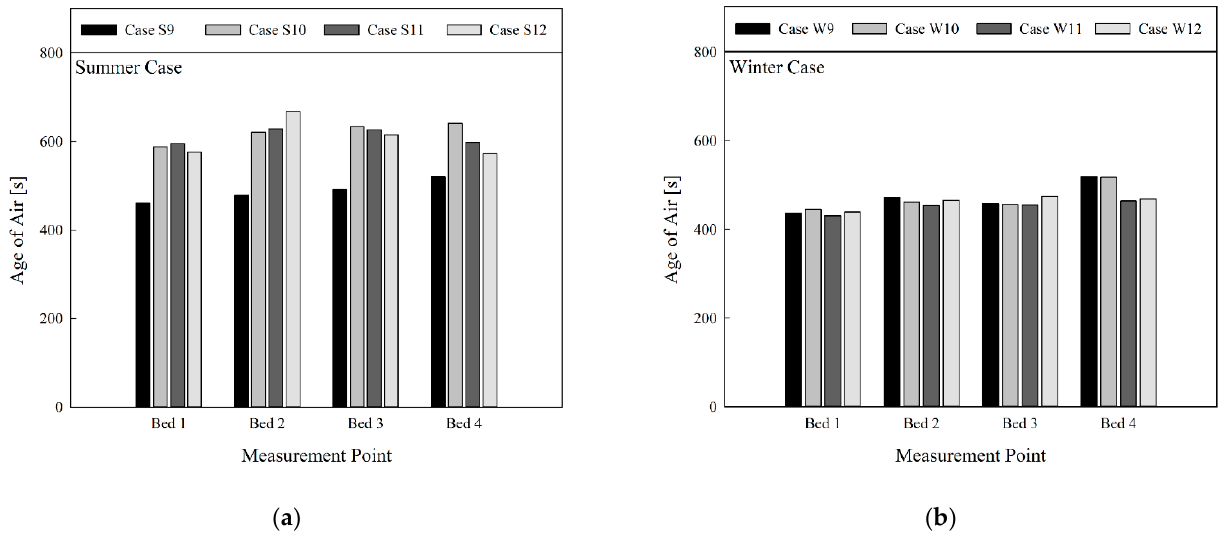
Figure 8. Comparison of age of air at bed location by season (in cases of ventilation system operation, four-way cassette fan coil unit operation, operation of air cleaner, and no use of curtain): ( a ) summer; ( b ) winter.